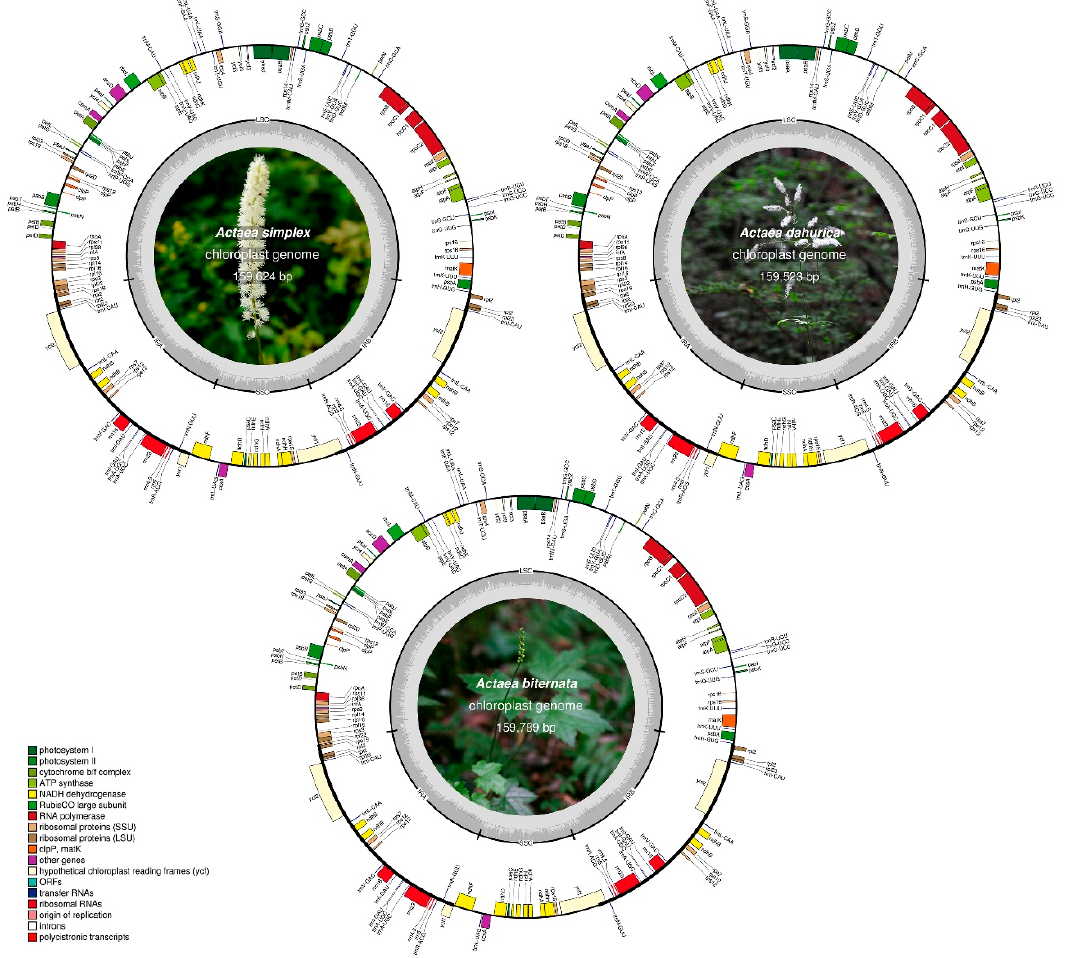
Figure 1. Graphical maps of the cp genomes of A. simplex , A. dahurica, and A. biternata . Genes drawn inside the outermost circle are transcribed clockwise, and those outside the circle are transcribed counterclockwise. Dark gray shading in the inner circle indicates the GC content. The inner photograph shows Actaea .